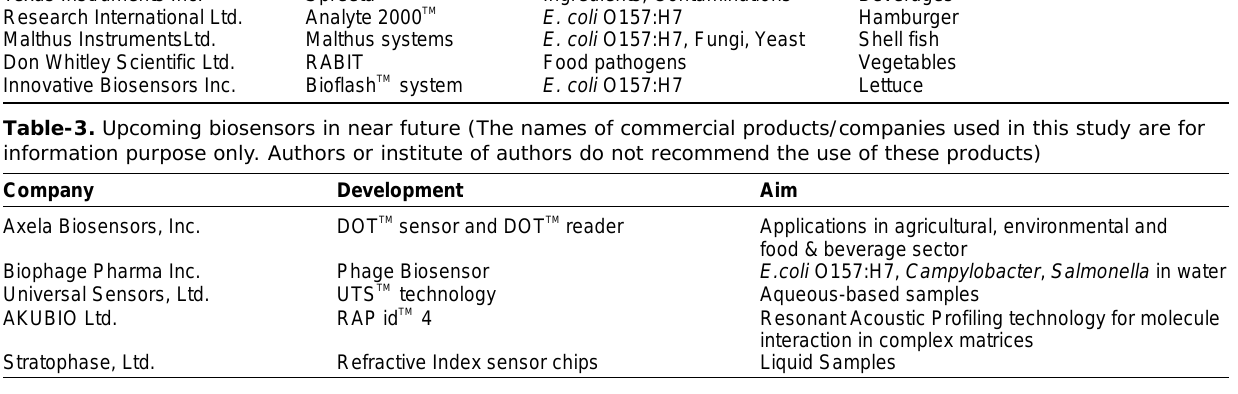
Table-2. Commercially available biosensors (The names of commercial products/companies used in this study are for information purpose only. Authors or institute of authors do not recommend the use of these products) Manufacturer